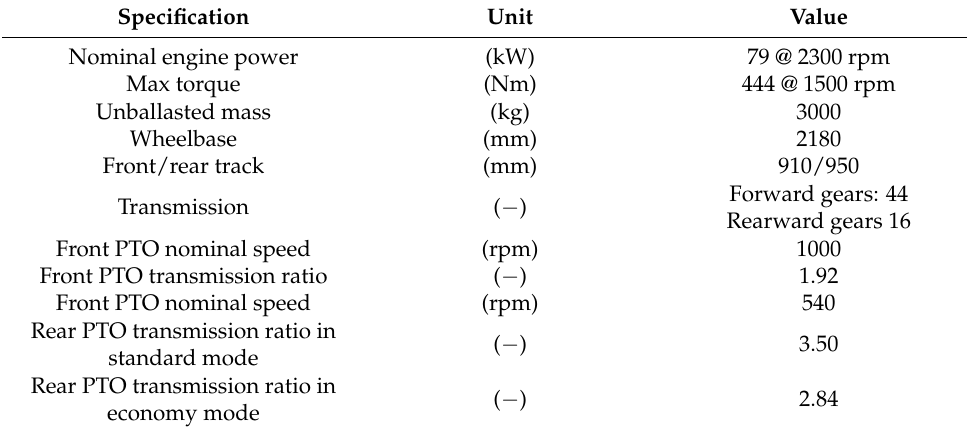
Table 1. Main tractor specifications.